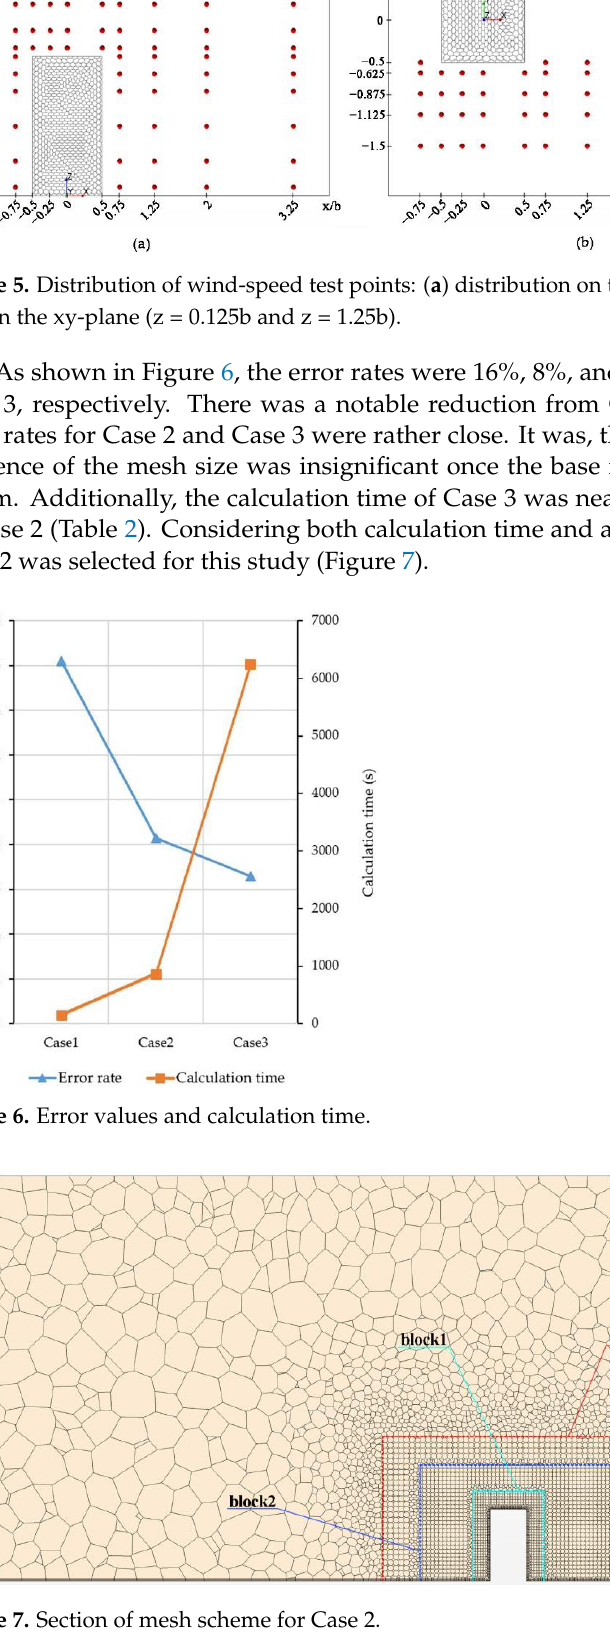
Figure 5. Distribution of wind-speed test points: ( a ) distribution on the xz-plane (y = 0), ( b ) distri- bution on the xy-plane (z = 0.125b and z = 1.25b).